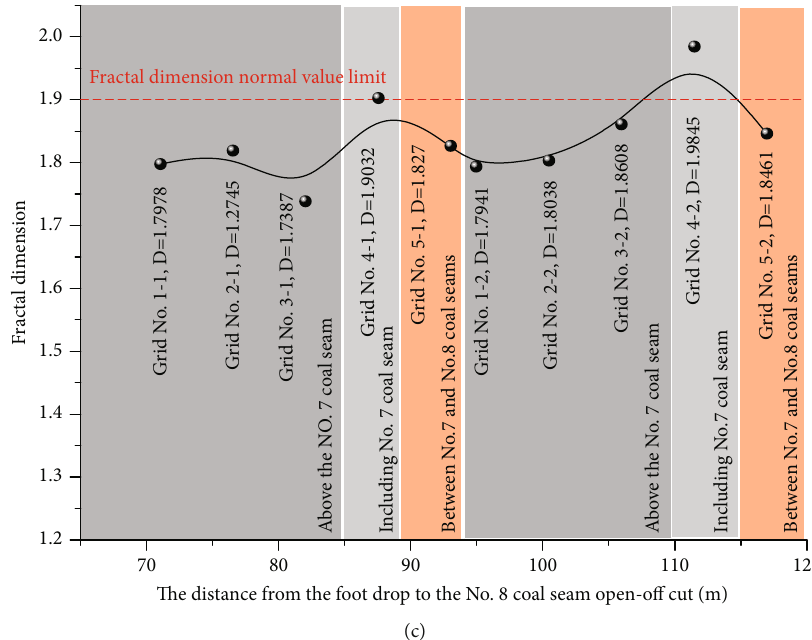
Figure 7: The calculation results of porosity and fractal dimension of each grid. (a) The relationship between fractal dimension and porosity. (b) The relationship between fractal dimension and vertical distance from coal seam No.8 ’ s fl oor. (c) The relationship between the fractal dimension and the distance from foot of perpendicular to coal seam No.8 ’